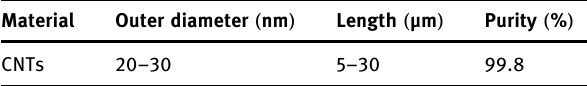
Table 1: Material characteristics of CNTs